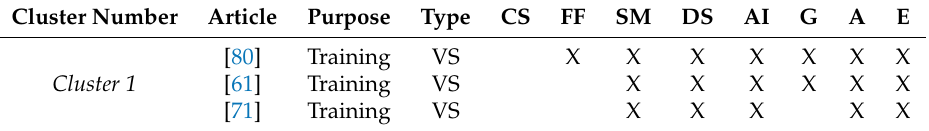
Table 2. Clusters generated according to the evaluation aspects—PA: Physical Application, VS: